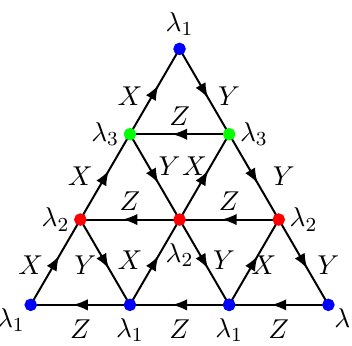
Figure 14 . The adjacency diagram of the dilute RSOS model associated to the Z 3 quiver theory, in the dynamical N = 4 -like picture. Vertices of the same colour/height λ are identified. This is the dual graph to the brane-tiling diagram of the quiver